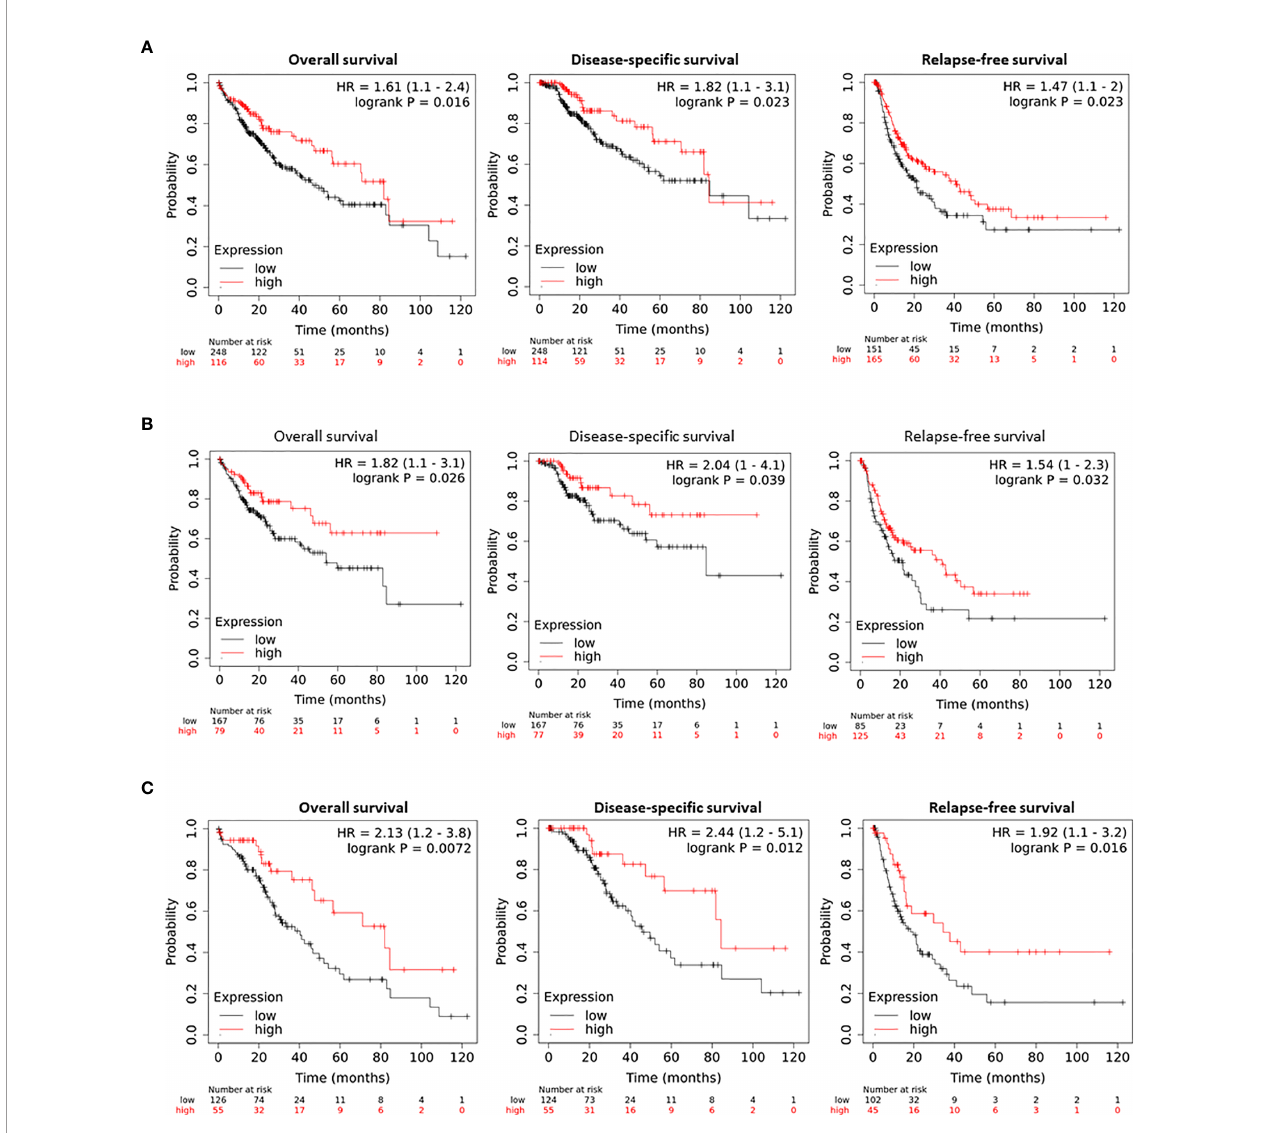
FIGURE 3 | Hepcidin correlates with a worse survival outcome in liver cancer patients. (A) Patient survival outcome was analyzed on the Kaplan-Meier Plotter platform. Hepcidin expression levels were ranged as 0-120133 and the cutoff value for hepcidin expression was set as 501 in the overall and disease-speci fi c survival analysis and 82 for the relapse-free survival using the minimum p-value approach as described (26). Case numbers in each group were listed at the bottom of the fi gure. (B) The cutoff value for hepcidin expression was 48 in the relapse-free survival comparison. (C) Hepcidin expression range was 0-66150 and the cutoff value was 511 for all three